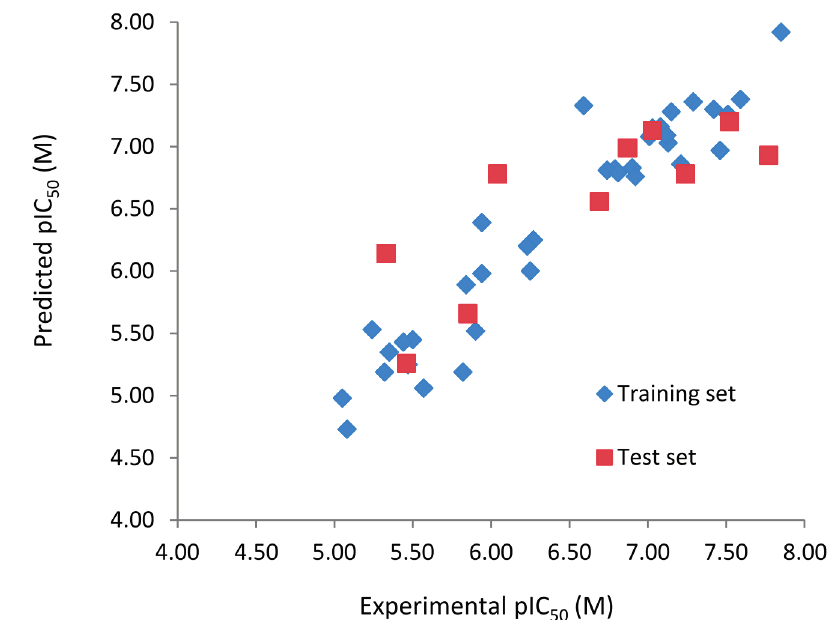
Figure 1. Experimental vs. predicted pIC 50 values of the training (blue) and test (red) sets obtained using the best model with the fragment distinction parameters A/B/C/Ch/DA